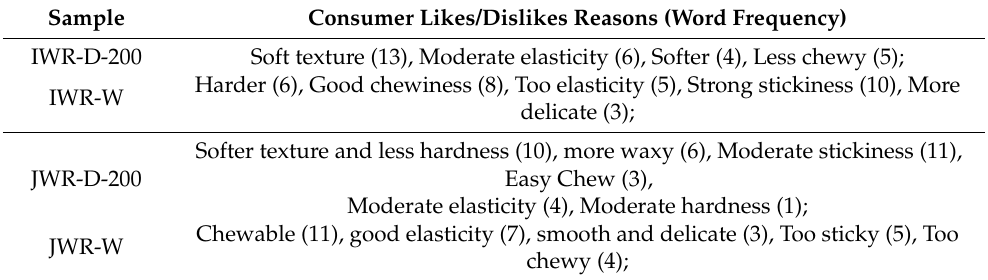
Table 5. Descriptors of samples in consumer testing.